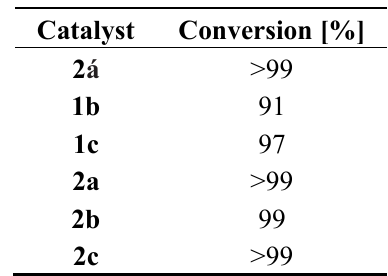
Table 3. Comparison of the catalytic activity of the complexes 1b – c , 2á and 2a – c for the test reaction shown in Scheme 2 a